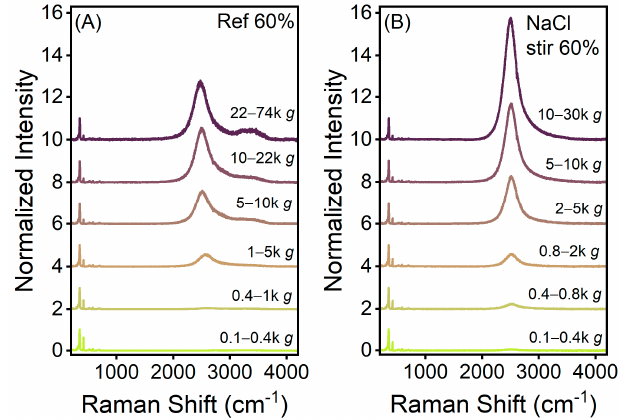
Figure A4. Raman spectra of liquid-phase exfoliated WS 2 nanosheet dispersions. Exfoliation was executed by tip sonication with a 60% amplitude. The spectra display the characteristic Raman signals of WS 2 . The PL of WS 2 is displayed around 2500 cm − 1 and negligible in dispersions containing large nanosheets but increases with the ML content of the dispersion. Signals around 3400 cm − 1 originate from water. ( A ) Reference, ( B ) Stirring in H 2 O/NaCl. The spectra of the different nanosheet sizes are vertically offset for